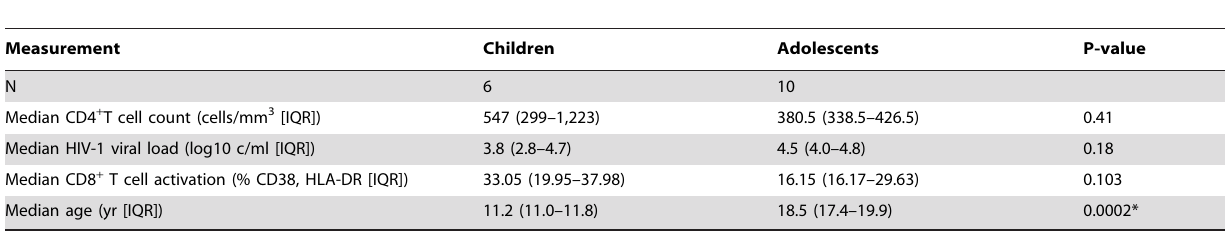
Table 1. Numbers, CD4 count, viral load, CD8 + T cell activation, and age of subjects in each group.